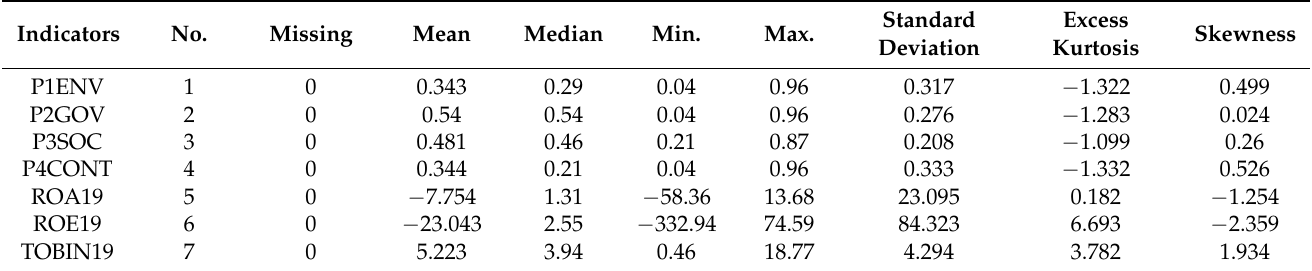
Table 1. Descriptive measures of the indicators.